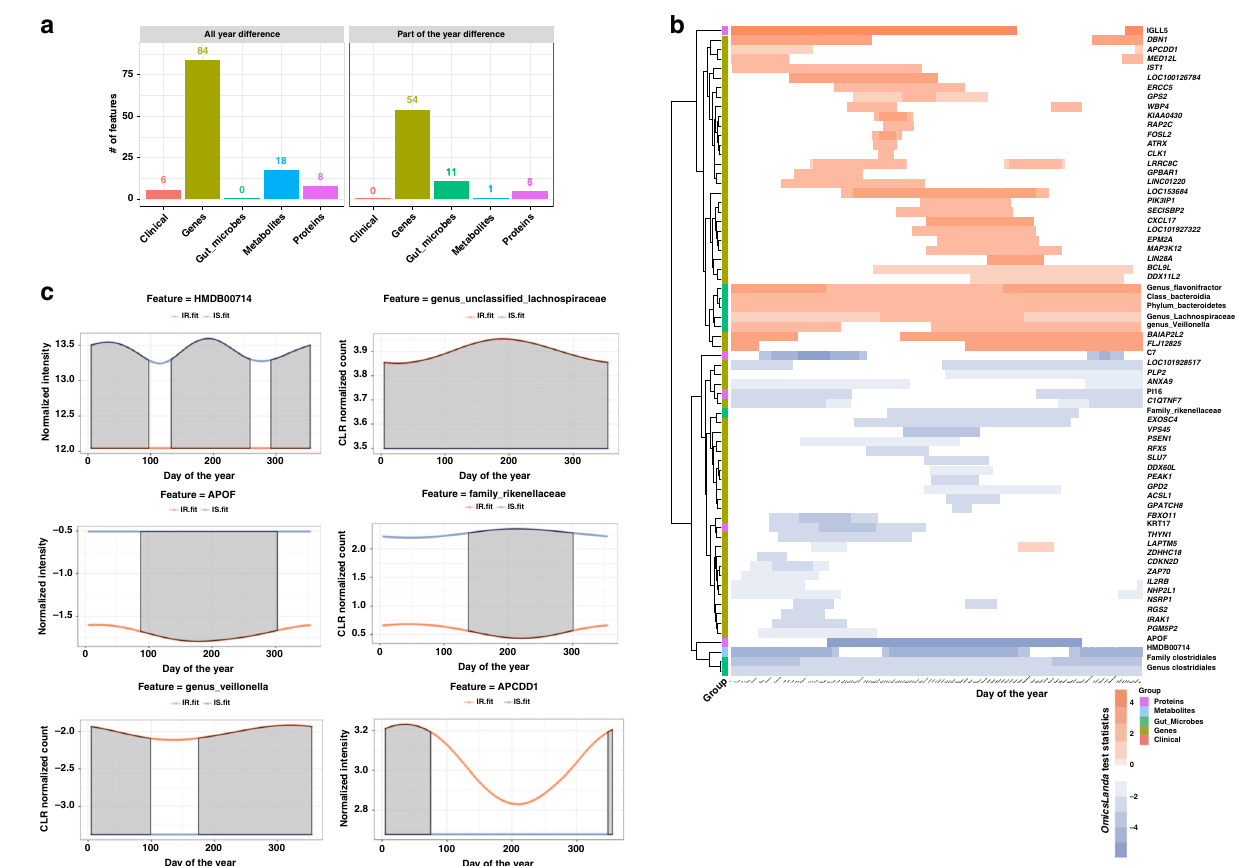
Fig. 6 IR and IS responses to seasons. a 187 analytes show seasonality difference between IR and IS, of which 116 features exhibit global differences between IR and IS throughout the entire year and 71 features show the statistical signi fi cance during part of the year ( OmicsLonDA permutation test p ≤ 0.05). b Examples of omics analytes that show signi fi cant differential abundance/expression between IR and IS subjects across the year. For each analyte, the orange curve represents fi tted curve for IR, and dark blue curve represents the fi tted curve for IS subjects. Gray shaded area between the two curves highlights time intervals when the corresponding feature is signi fi cantly different between the two groups (IR and IS). c Signi fi cant time intervals of analytes that show differences between IR and IS in part of the year. Each row represents an analyte, and the shaded area represents the time of the year that each corresponding feature shows a signi fi cant difference between IR (orange) and IS (blue) based on OmicsLonDA test statistics of each time